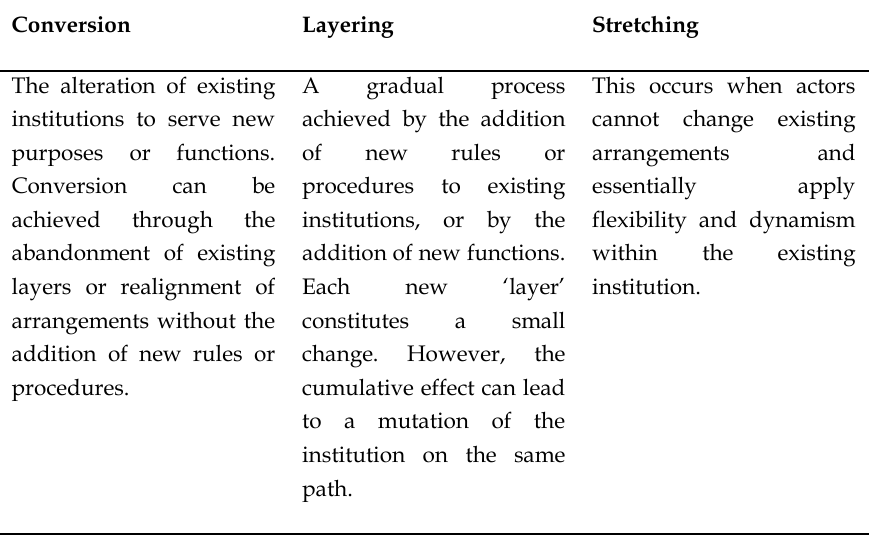
Table 3. Three forms of Institutional